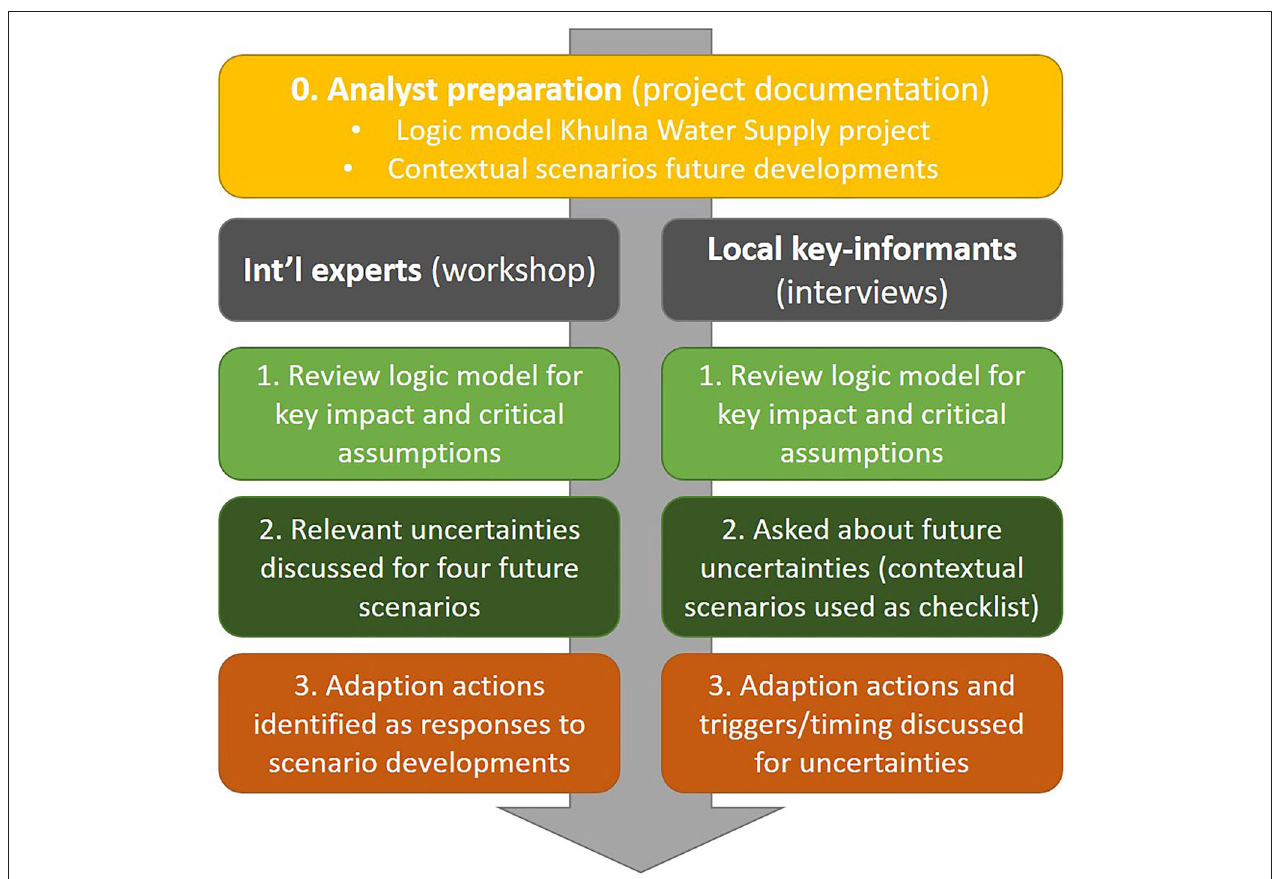
FIGURE 2 | Application of the adaptive planning approach for the Khulna Water Supply project